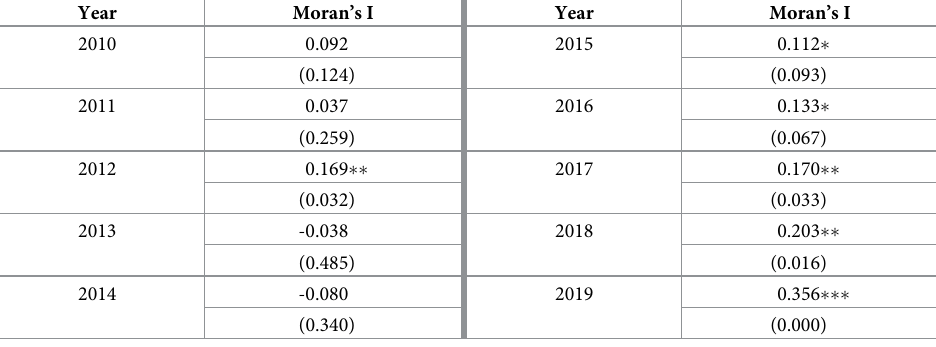
Table 4. Spatial correlation of the coupling coordination development of energy-economy-carbon emission system.